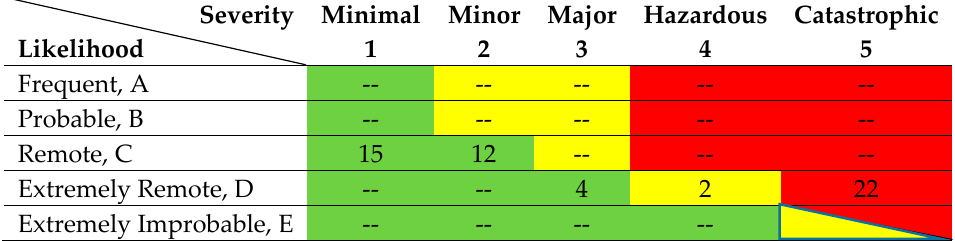
Table 14 . Risk matrix with look ‐ ahead time 180 s, overtaking scenario.04 Table 14. Risk matrix with look-ahead time 180 s, overtaking scenario. Table 14 . Risk matrix with look-ahead time 180 s, overtaking scenario. Table 14 . Risk matrix with look-ahead time 180 s, overtaking scenario. Table 14 . Risk matrix with look-ahead time 180 s, overtaking scenario.